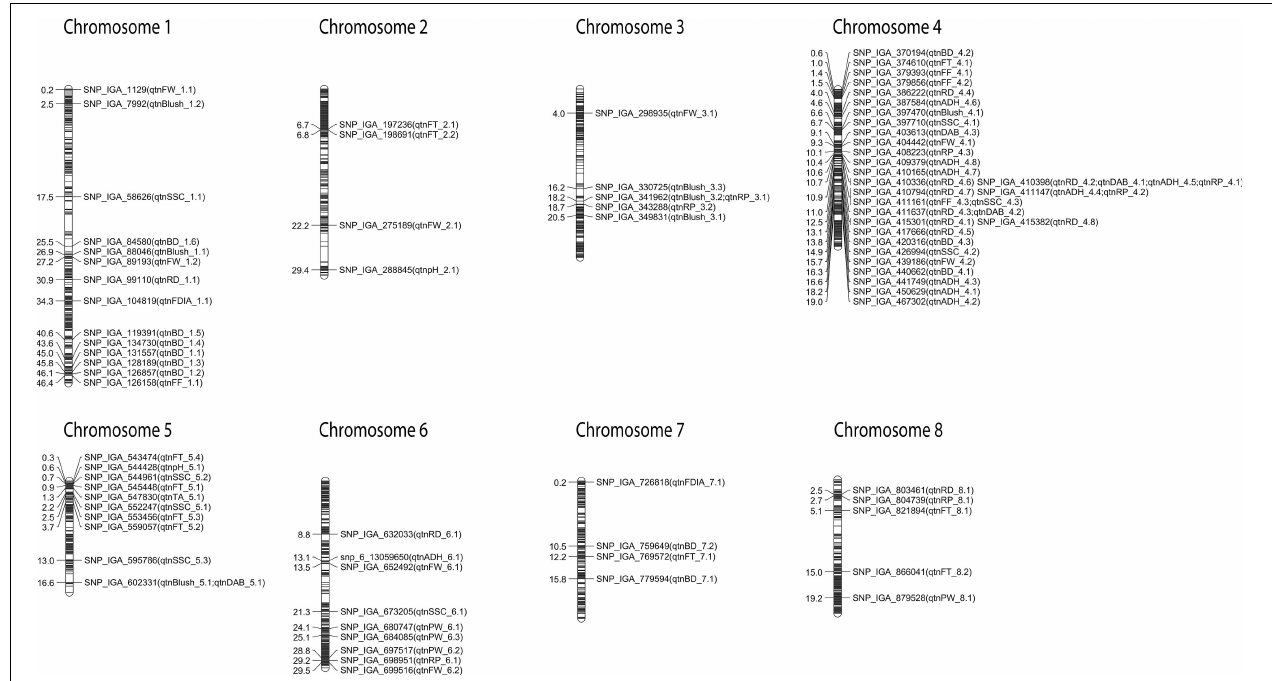
FIGURE 1 | Reliable QTNs detected using different multi-locus GWAS methods and/or at least two seasons. Genetic distance scale in physical position (Mbp) is placed at left margin.